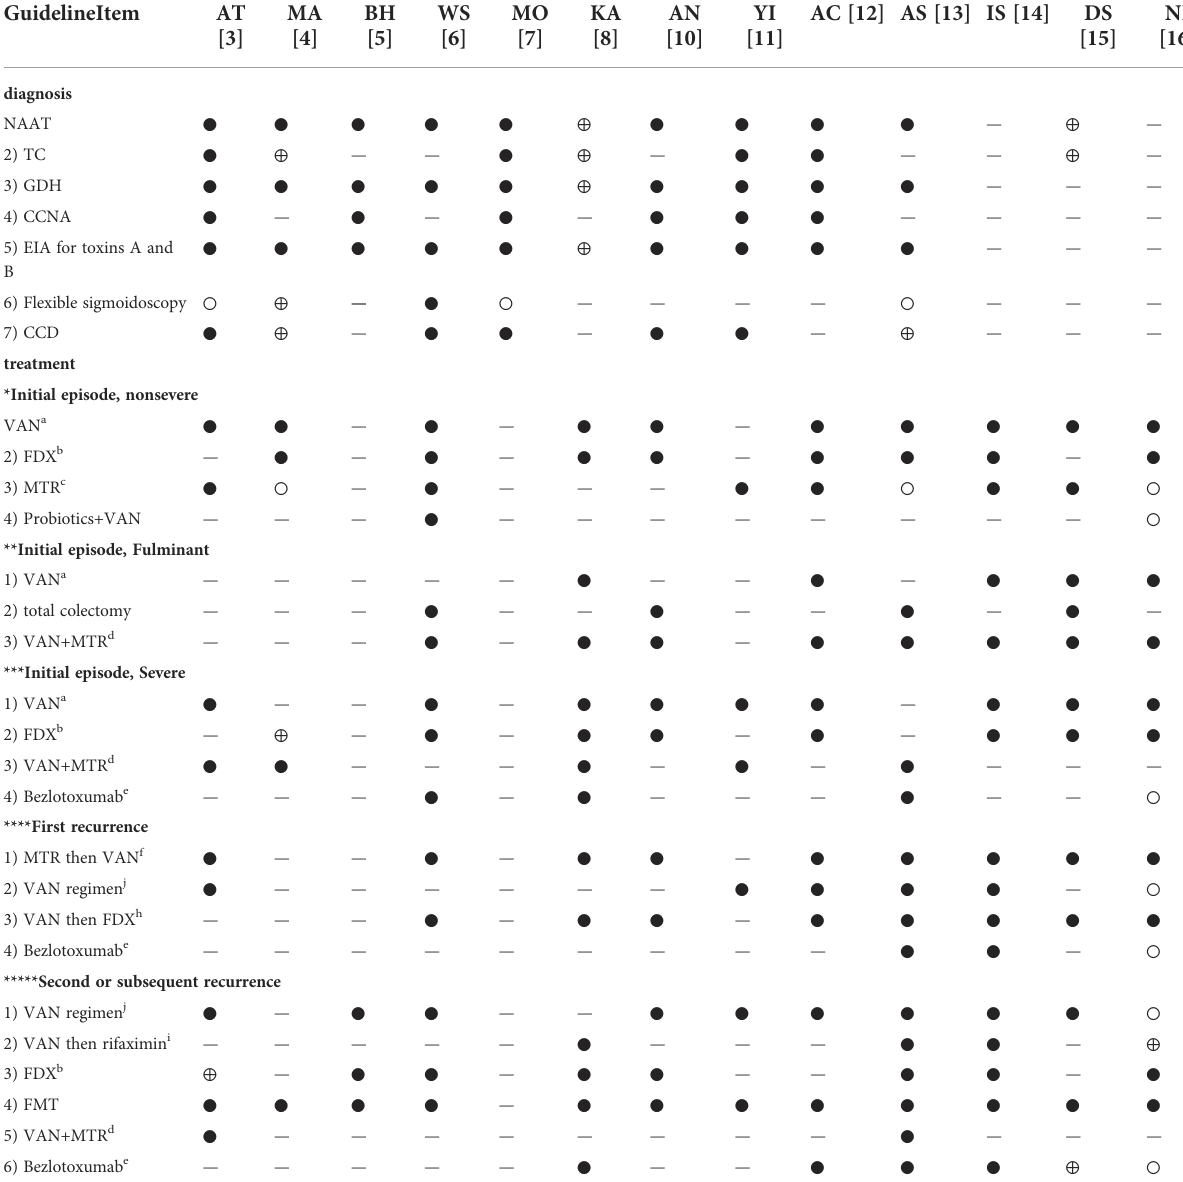
TABLE 3 Recommendations for the diagnosis and therapy of Clostridium dif fi cile infection in the included guidelines. GuidelineItem